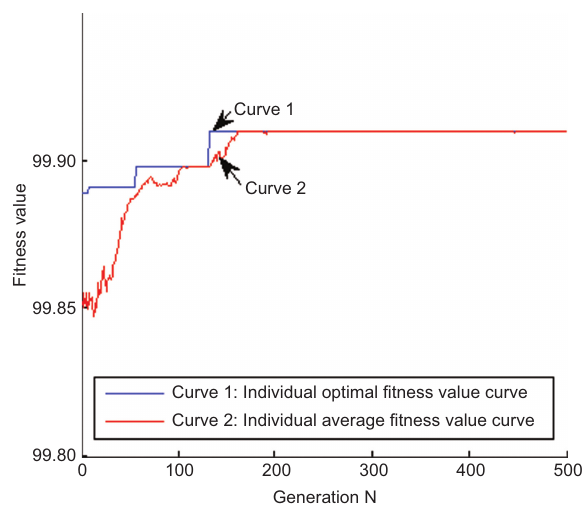
Figure 13. The Convergence Curve when the Mutation Probability is Set to (0.006,